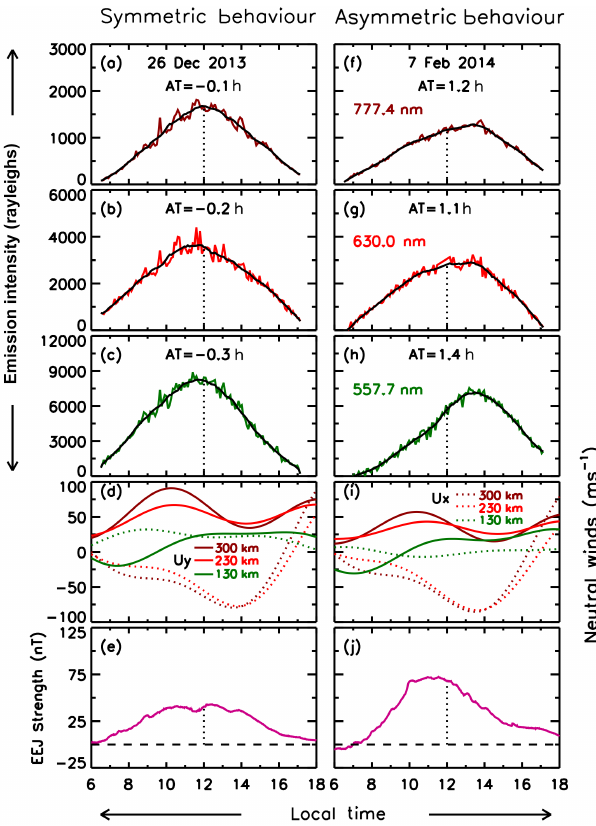
Figure 4. Top row (a, f) shows the diurnal variability in OI 777.4nm on 2 selected days. Plots (b, g) and (c, h) show the diurnal behaviour of OI 630.0nm and OI 557.7nm emissions on the same days as of OI 777.4nm emissions. Plots (d, i) show the HWM14 neutral wind magnitudes. Plots (e, j) show the electrojet strengths. The plots in the left column show the symmetric diurnal behaviour in all three oxygen dayglow emission intensities, while those on the right rep- resent the day with asymmetric diurnal behaviour in all the dayglow emission